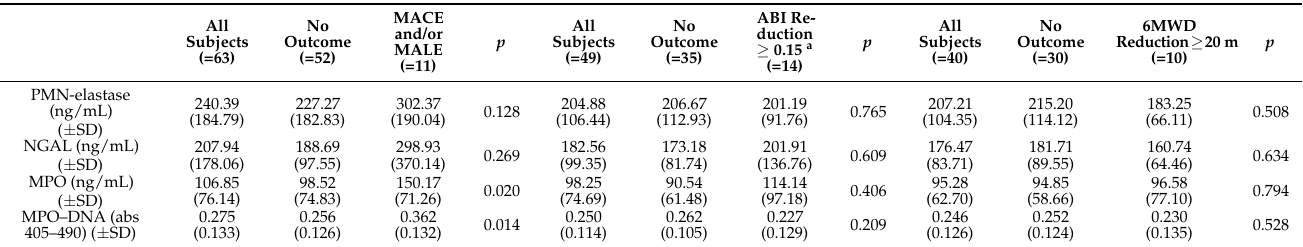
Table 2. Markers of neutrophil activation at baseline in patients with symptomatic chronic PAD with and without outcomes at 6 months.